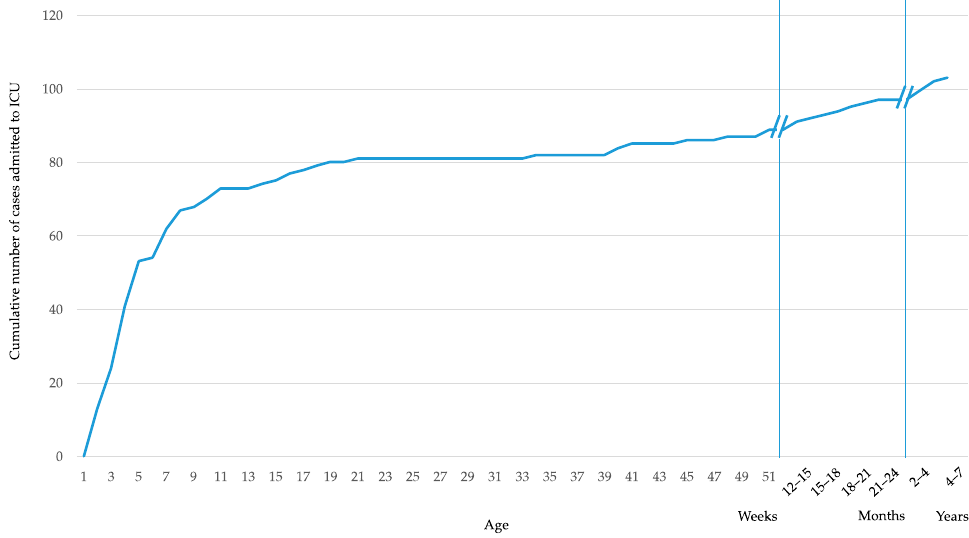
Figure 3. Cumulative number of cases admitted to the Intensive Care Unit.